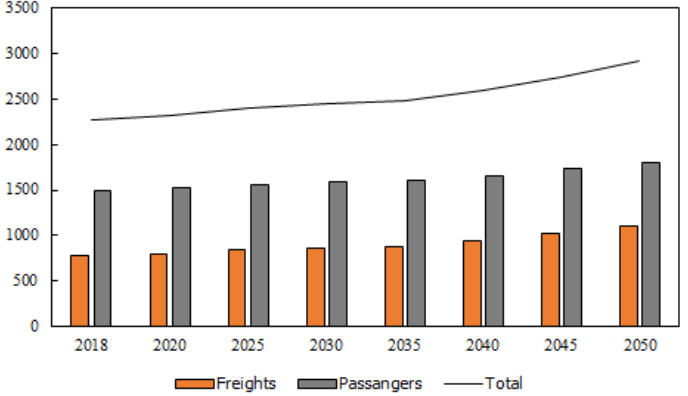
Figure 4. Energy consumption (in million toe) in road transportation for passengers and